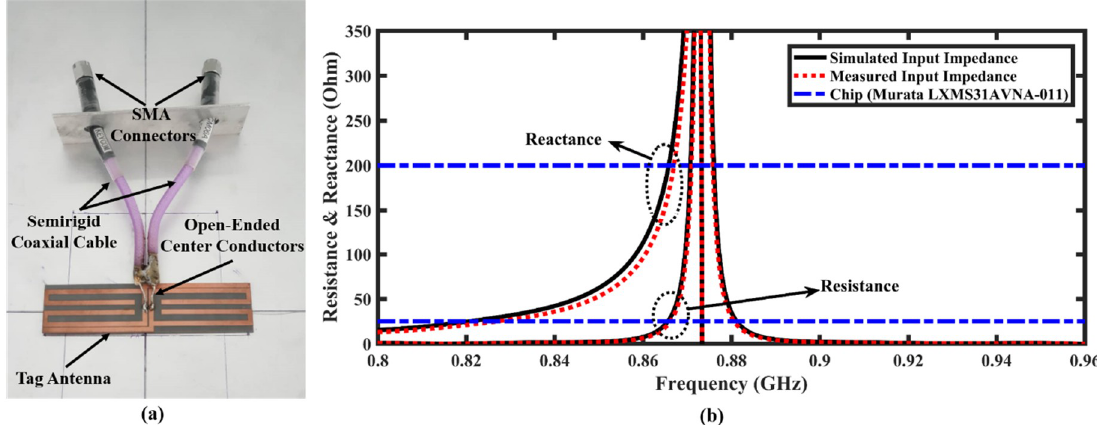
Figure 5. ( a ) di ff erential probe method; ( b ) simulated and measured tag antenna’s Figure 5. ( a ) differential probe method; ( b ) simulated and measured tag antenna’s impedance.